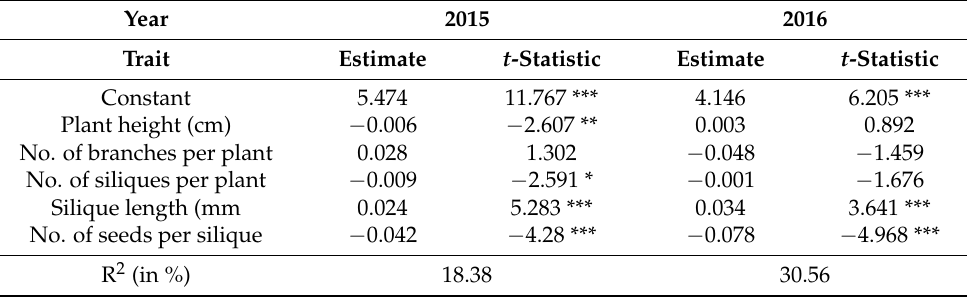
Table 2. Results of the regression analysis of individual features per thousand seed